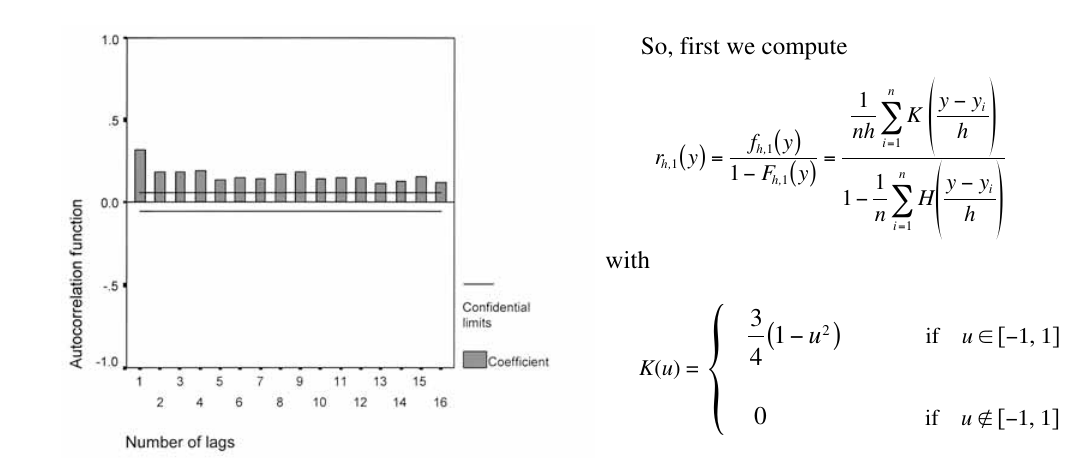
Fig. 5. Sample autocorrelation function for { (cid:54) t